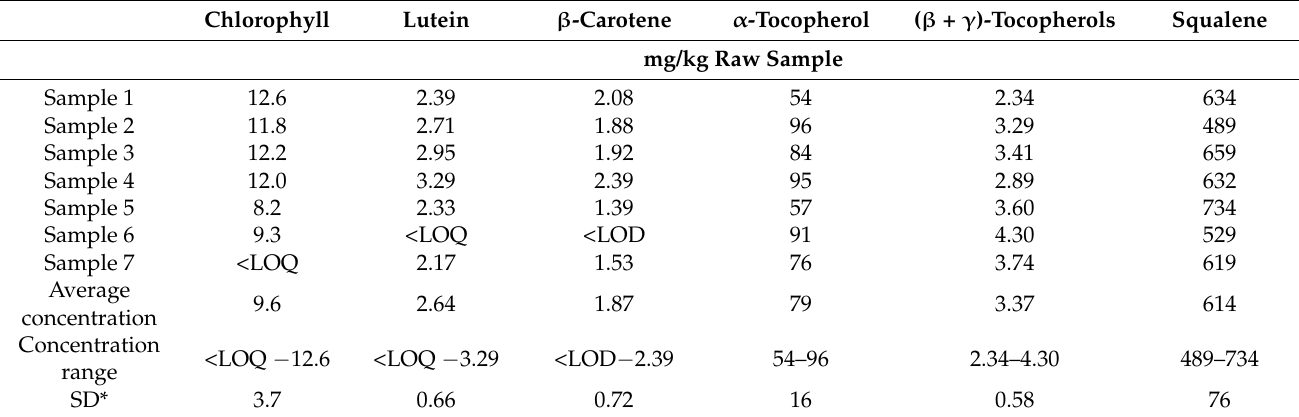
Table 5. Results for pigments, tocopherols and